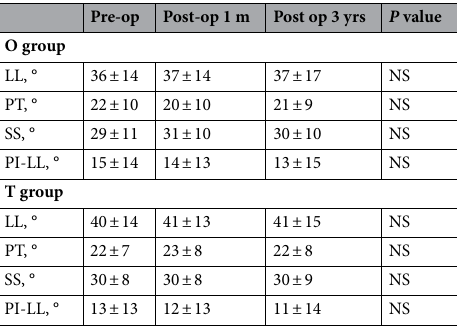
Table 2. Average change of spinal parameter. Pre-op indicates preoperative; Post-op1m, postoperative 1 month; Post-op 3yrs, postoperative 3